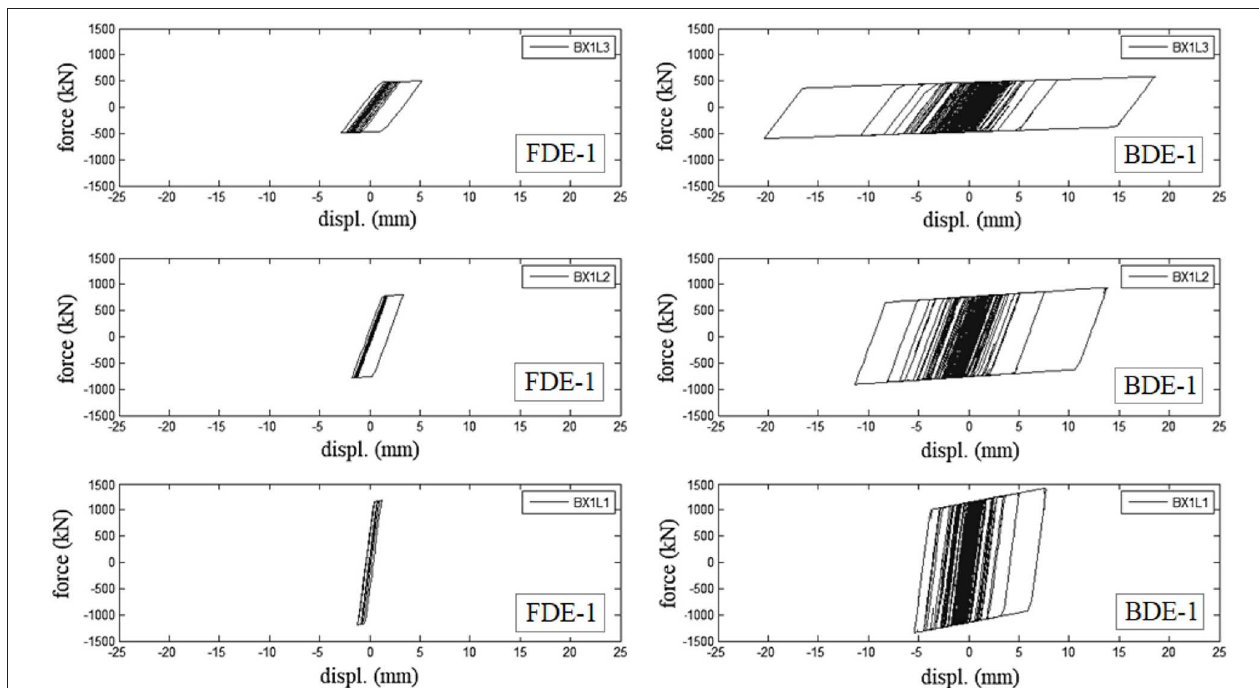
FIGURE 7 | Force-displacement response of DBs installed in position No. 1 at each story level (L1:L3) of the longitudinal frame (dir. X) of block B during FDE-1 (left) and BDE-1 (right) ground